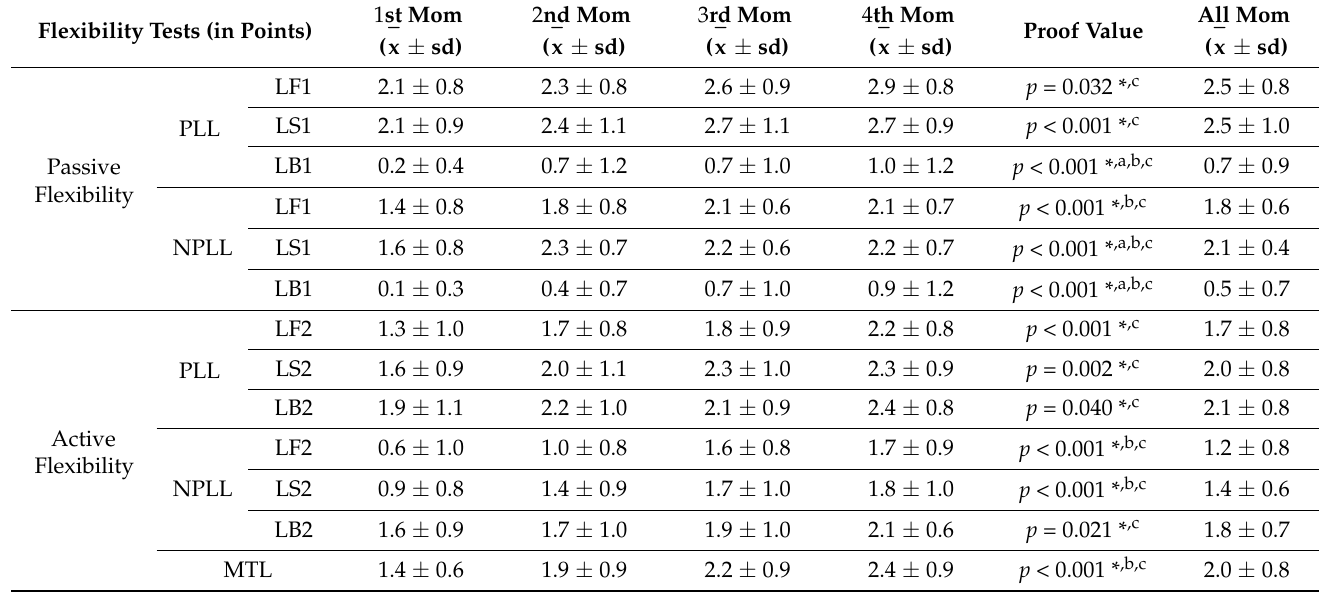
Table 1. Results and comparison of flexibility tests in the four moments of evaluation.